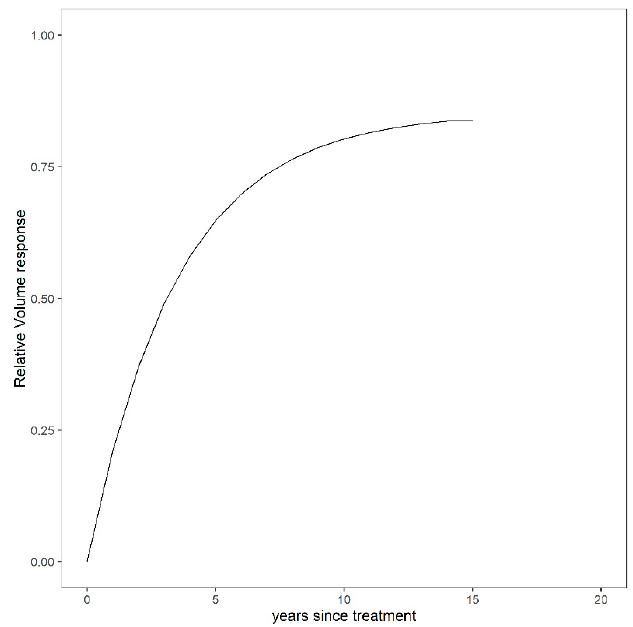
Figure 4. Hypothetical relative volume response for any treatment over time (years since the treatments were established).